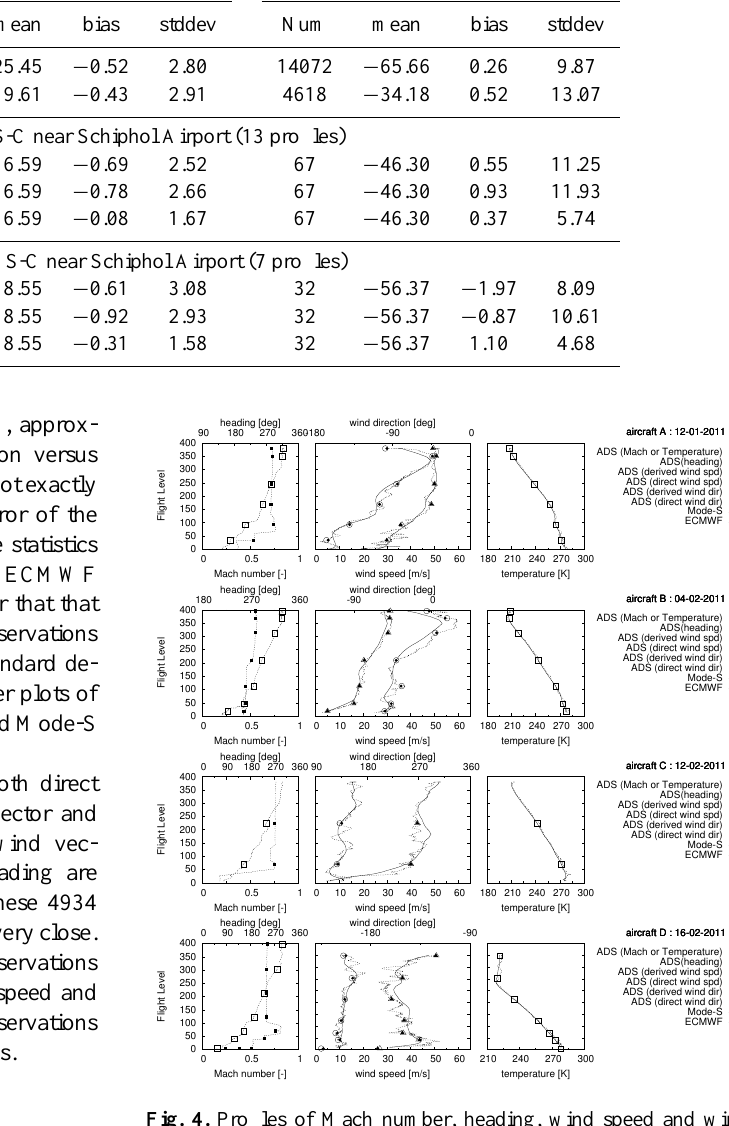
Table 4. Statistics of the comparison of wind observations from ADS-C versus ECMWF. Wind Speed Wind Direction